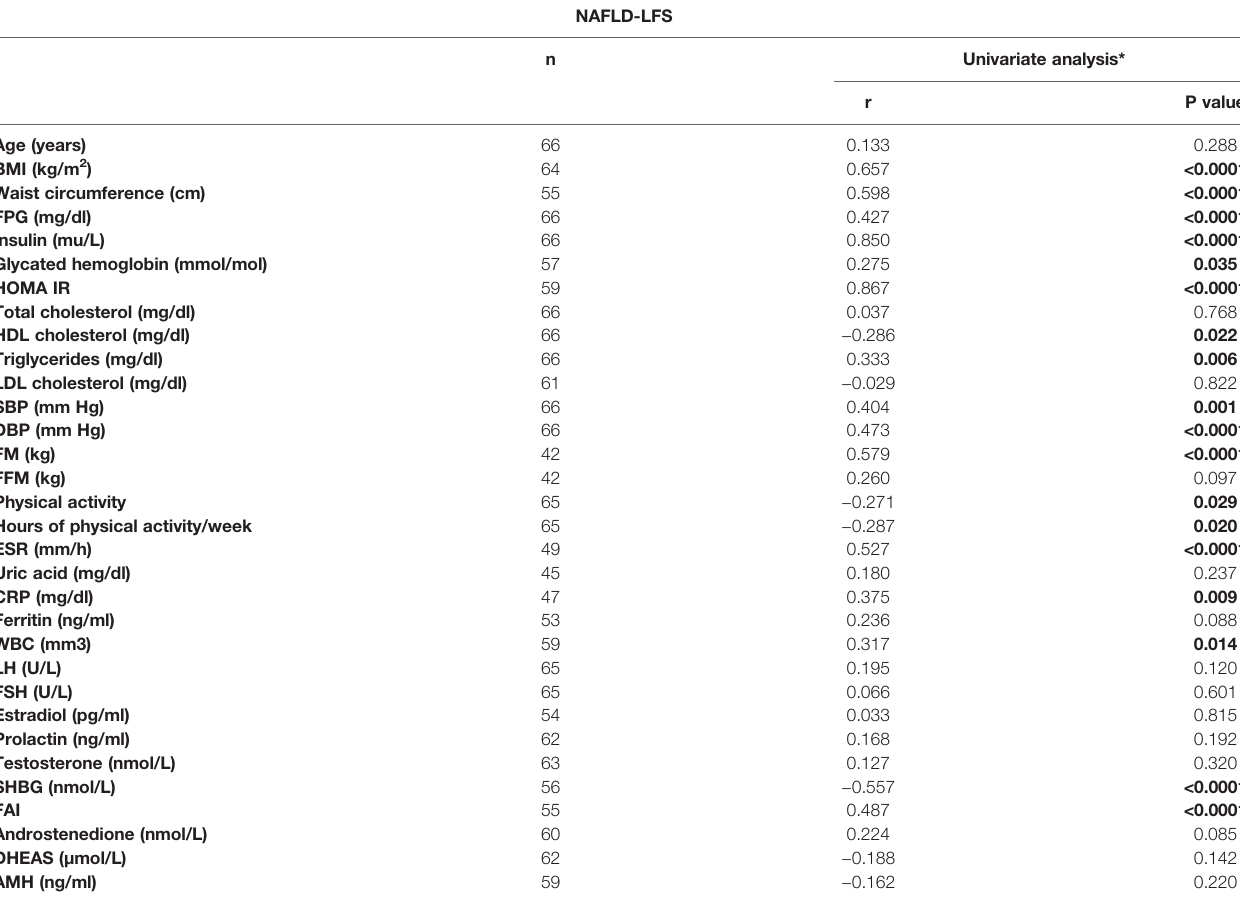
TABLE 2 | Associations between NAFLD-LFS and clinical and laboratory